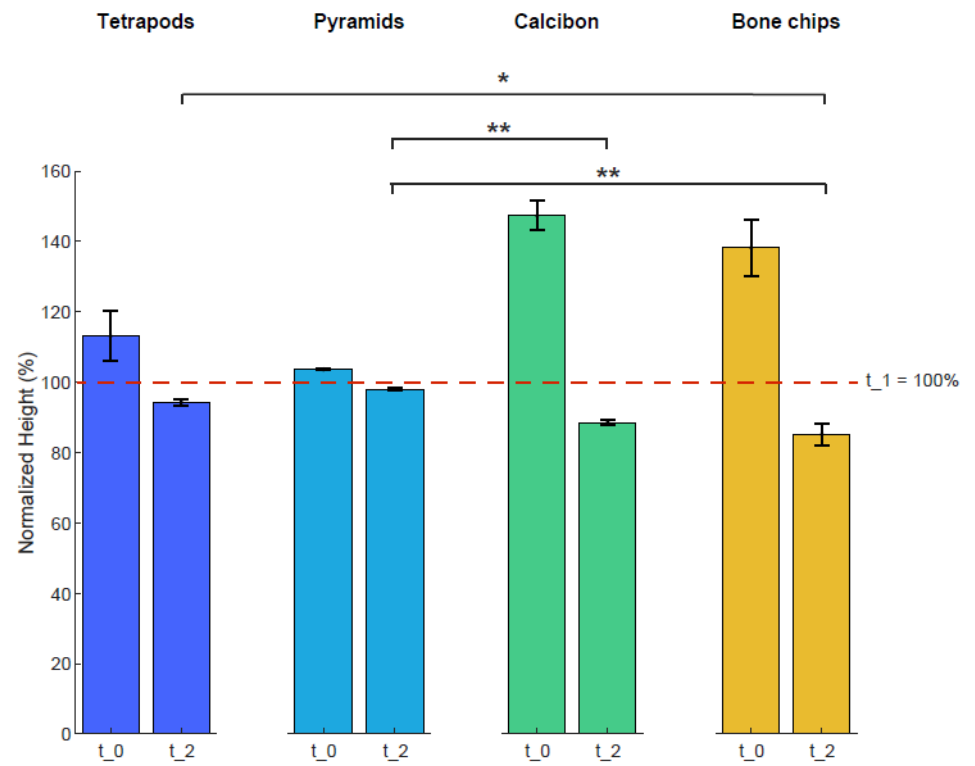
Figure 4. Heights of the four bulk materials before and after mechanical loading. The height of each sample was normalized to that of timepoint t_1 at 100%. Shown are mean and standard deviation values at t_0 and t_2. Statistically significant differences between the materials are shown for timepoint t_2 with ∗ = p < 0.05 and ∗∗ = p < 0.01.